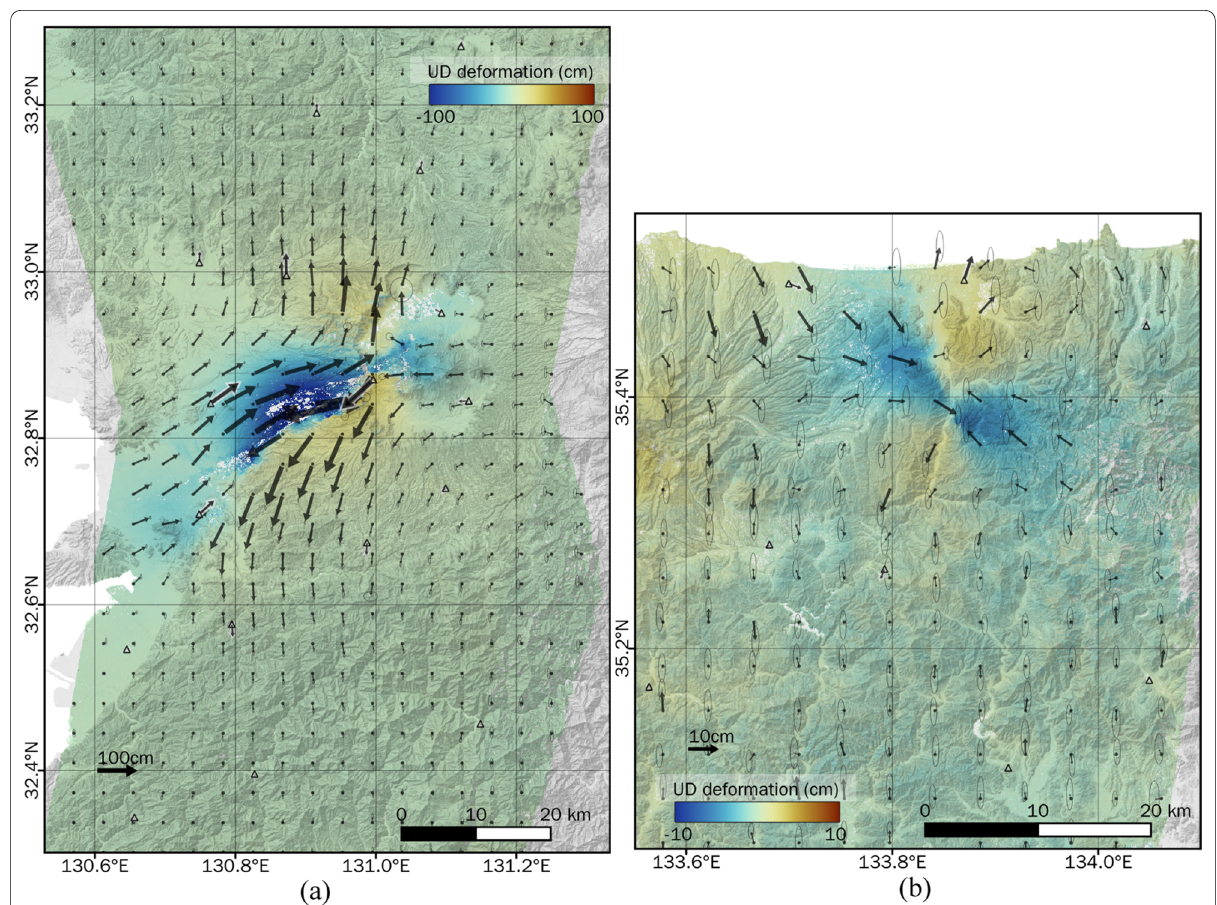
Fig. 5 SAR- and GNSS-derived 3D deformation. Black triangles denote GNSS CORS. a Kumamoto, b Tottori. Ellipsoids denote the standard errors of the SAR-derived 3D deformation